Question: Express in one sentence what the figure is showing.
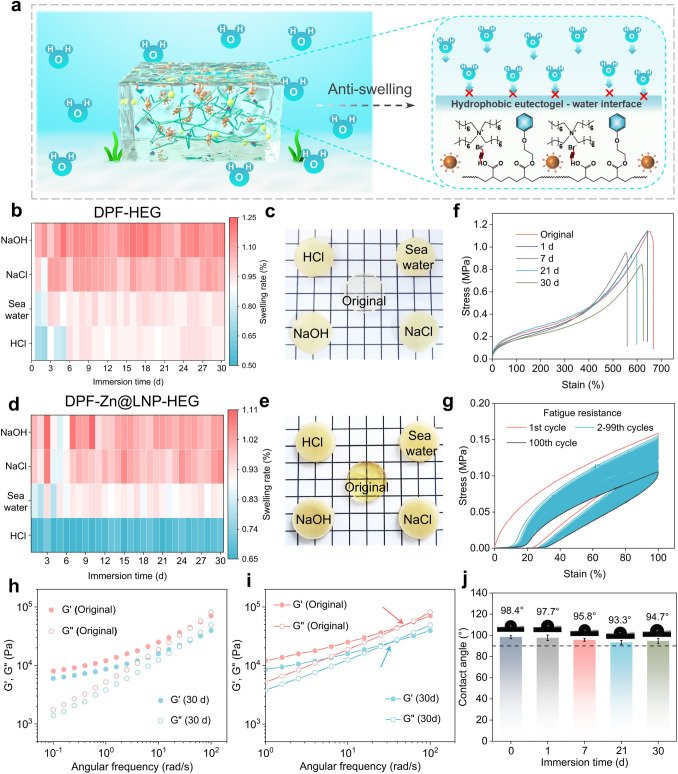
Answer: Hydrophobic and anti-swelling properties of DPF-Zn@LNP-HEG. a Schematic diagram of the water-repelling mechanism enabled by hydrophobic chains in DPF-Zn@LNP-HEG network. b–e Swelling ratios and corresponding photographs of DPF-HEG and DPF-Zn@LNP-HEG after 30 days of immersion in various aqueous media. f Stress–strain curves of DPF-Zn@LNP-HEG after seawater immersion for different periods. g Cyclic tensile loading–unloading curves of DPF-Zn@LNP-HEG over 100 cycles at 100% strain after 30 days of seawater immersion. h, i Frequency-sweep modulus variations of DPF-Zn@LNP-HEG before and after seawater immersion. j Water contact angle variations of DPF-Zn@LNP-HEG after seawater immersion for different durations